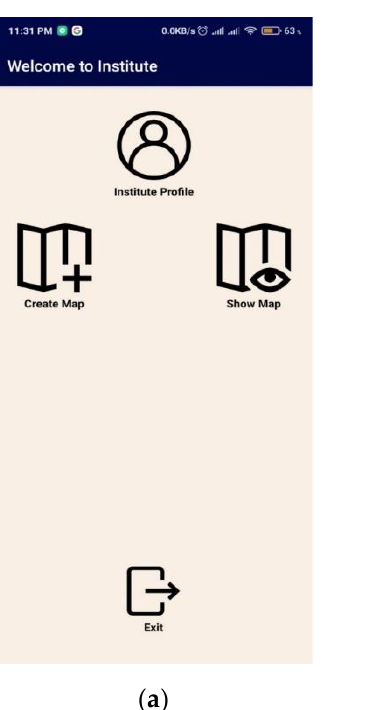
Figure 12. Surface map creation of an Institution ( a ) by selecting an area, ( b ) setting a name of the chosen location, and ( c ) displaying created map, which is visible to all users.